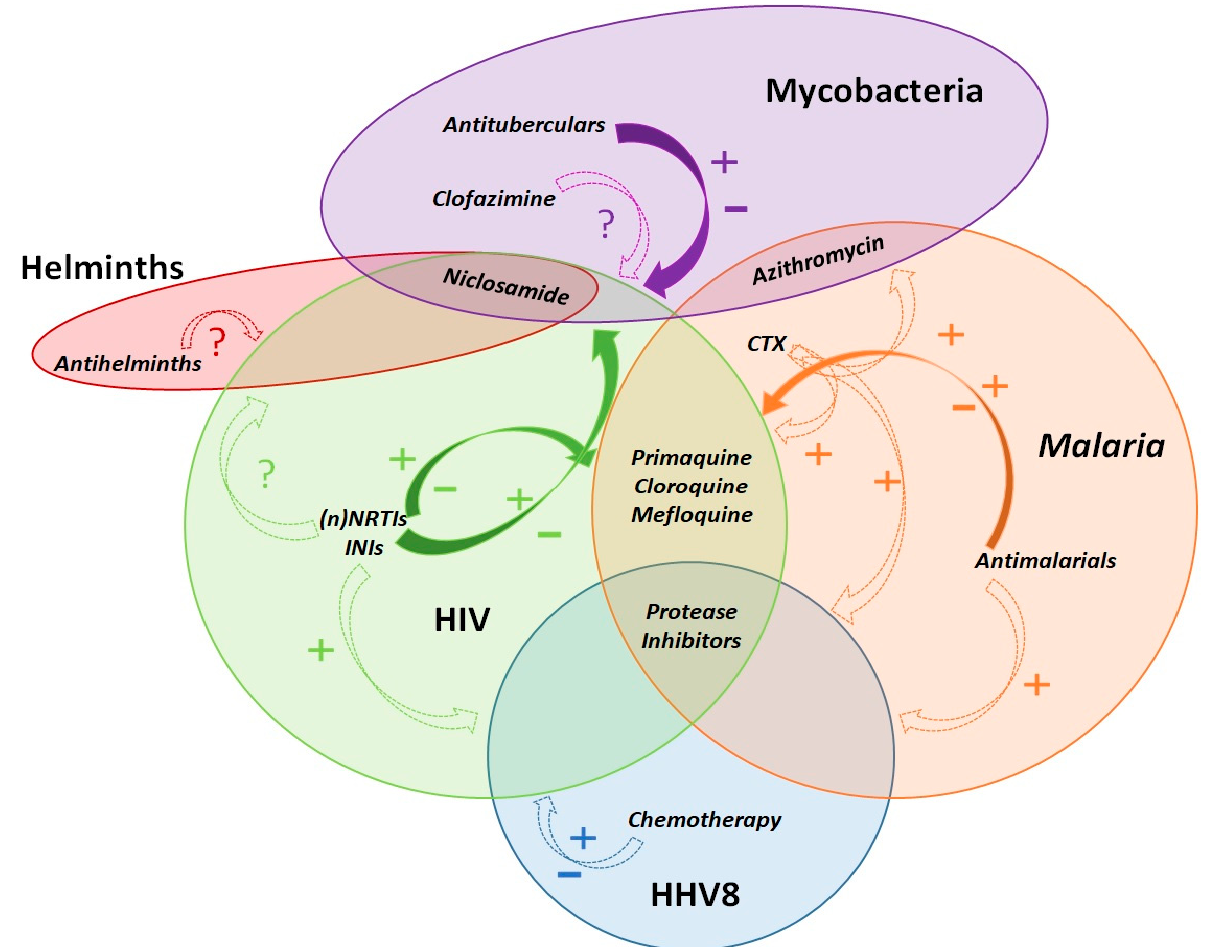
Figure 5. Schematic summary and exemplary representation of observed and uncertain favourable and negative, direct and indirect pharmacological activities of co-administered treatments for HIV and concurrent co-infections. Dashed arrows represent the potential indirect effects of the drug on co-infections, mediated by immunological and/or clinical effects upon their main infective target. Continuous filled arrows represent potential or already known direct effects of the drugs, mediated by pharmacological drug–drug interactions, and they can include also indirect effects through immunological and/or clinical aspects of the disease course. Drugs included within the circles have a direct activity upon the infectious agent causing the specific disease. As an example, some antiretrovirals have known negative and potentially positive direct interactions with drugs prescribed for tuberculosis and malaria; protease inhibitors have also a direct activity upon Plasmodium spp. and HHV-8; despite antiretrovirals may not have relevant or common drug-drug interactions with Kaposi sarcoma chemotherapy or anthelmintics, they still have an indirect positive effect upon the evolution of HHV8-related malignancies and helminths co-infections through virological suppression and immunological recovery. Depending on the overlap and co-occurrence of two or more of the depicted diseases, as well as of many others not represented here, this figurative model should lead to prefer a single best therapeutic scheme with the lowest risk of negative drug–drug interactions and the highest potential of boosting or enhancing activities. Legend: +, potential favourable effects; − , potential negative effects; ?, uncertainty about any possible effect; CTX, cotrimoxazole; (n)NRTIs, (non)Nucleoside